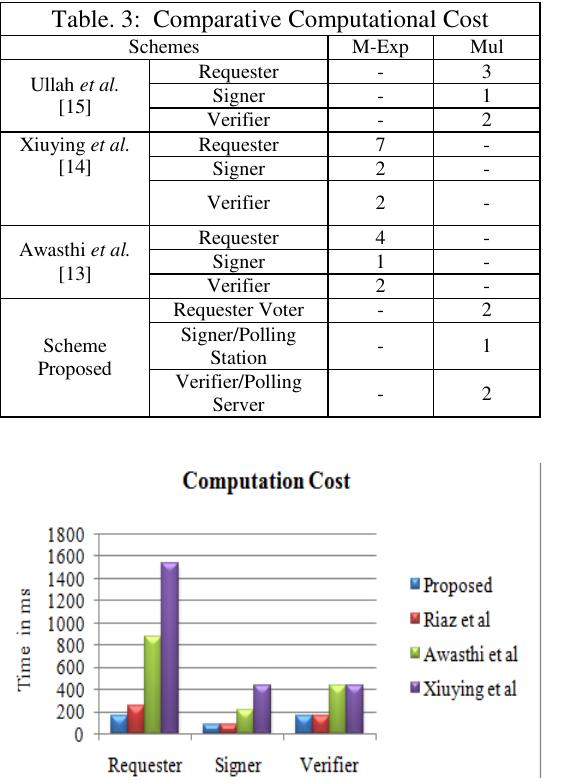
Table. 3: Comparative Computational